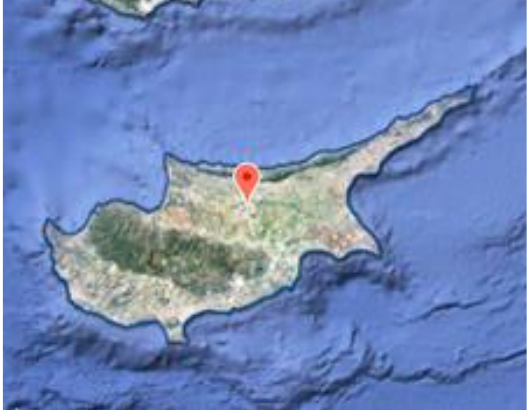
Figure 1. Location of the AERONET station Nicosia at the Cyprus Atmospheric Observatory (CAO) station (35.1406° N, 33.3814° E, 181 m a.s.l.) in Nicosia, Cyprus [31].